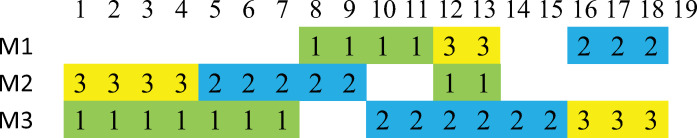
A Gantt chart for the schedule 1-3-2-2-1-3-3-1-2 of Example 2.